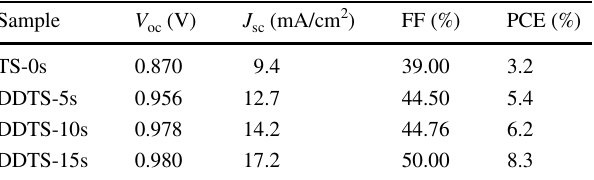
Fig. 7 External quantum efficiency (EQE) spectra using perovskite regulated time delay (from 0 to 15 s) Table 1 Photovoltaic-performance parameters (short-circuit photo- current, open-circuit photovoltage, fill factor, and power-conversion efficiency) extracted from J–V measurements for devices under 1 sun illumination (AM 1.5G, 100 mV cm −2 ) for 10